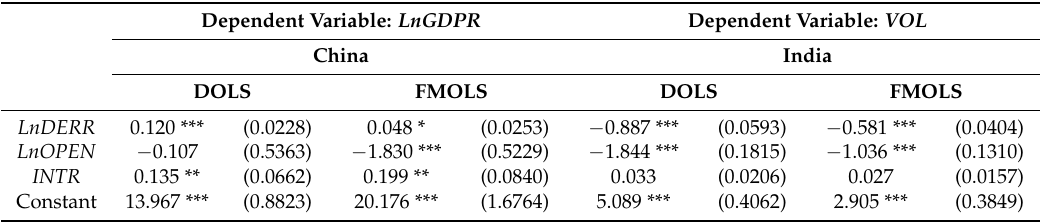
Table 6. Long-run impact of the derivatives markets on economic growth and growth